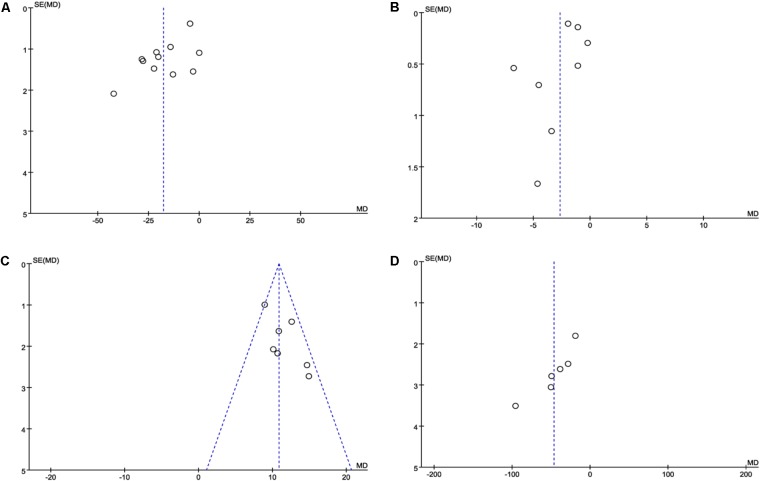
Funnel plot for the publication bias. (A) The plot of ET-1, (B) the plot of hsCRP, (C) the plot of NO, and (D) the plot of vWF. The funnel plots of these factors were symmetric, indicating that the publication was small.